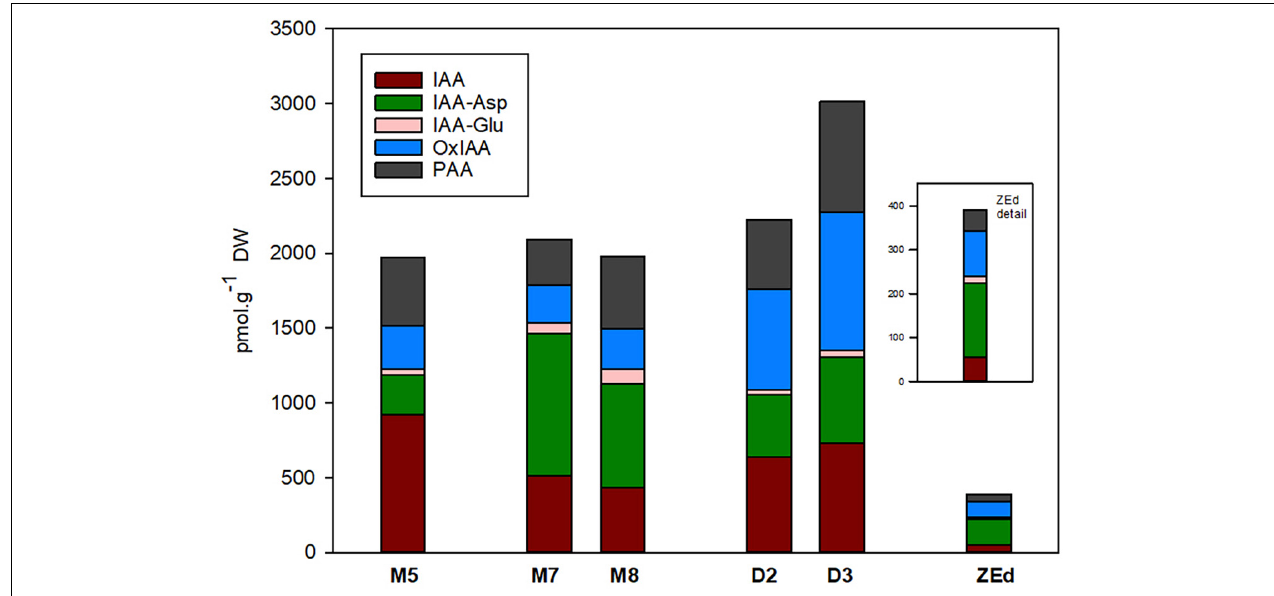
FIGURE 7 | Content of auxins and their derivatives in P. abies somatic (SEs) and zygotic (ZEs) embryos. M5 – mature SEs after 5 weeks of maturation, M7 and M8 – SEs after 7 and 8 weeks of prolonged maturation, D2 and D3 – SEs after 2 and 3 weeks of desiccation, ZEd – dry ZEs. IAA, indole-3-acetic acid; IAA-Asp, IAA-aspartate; IAA-Glu, IAA-glutamate; OxIAA, oxo-IAA; PAA, phenylacetic acid.